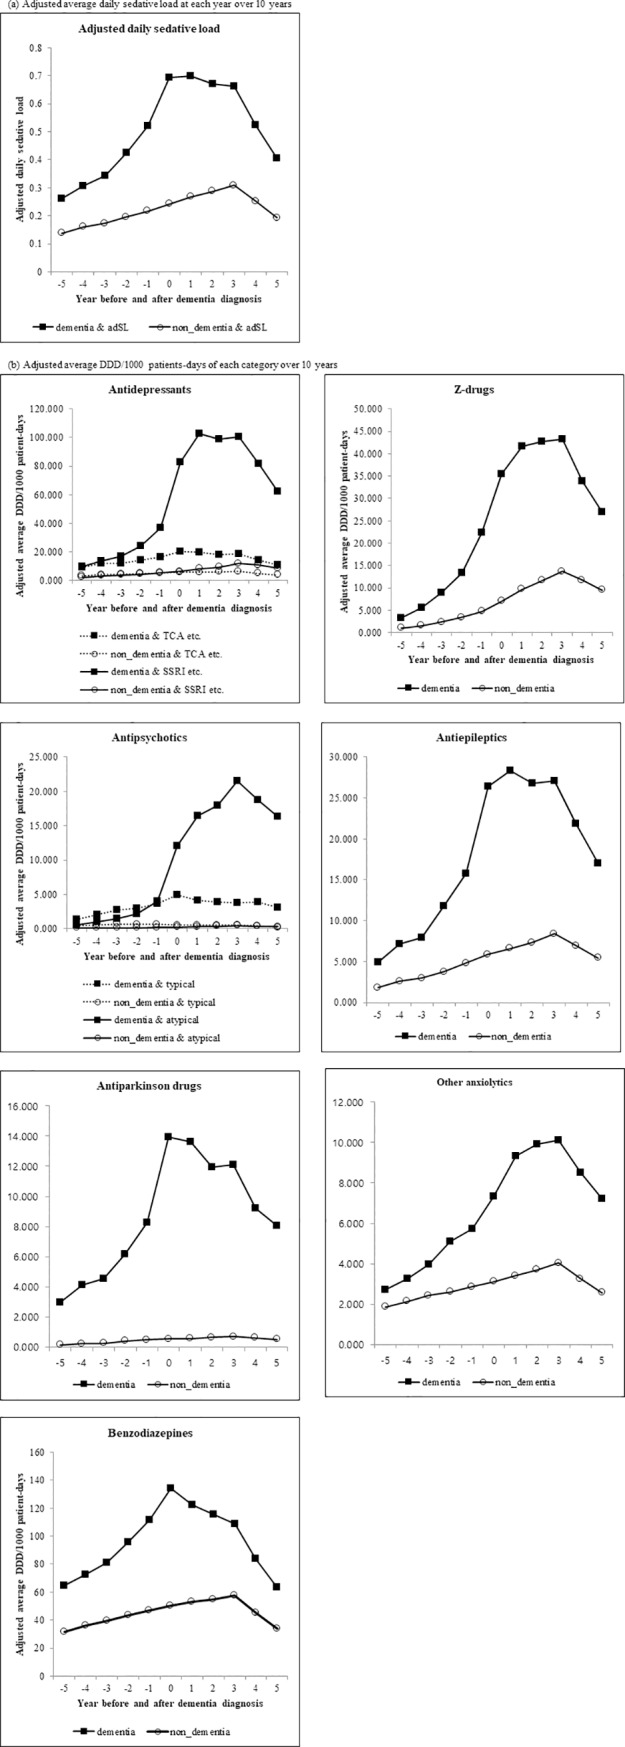
The trend of sedative load and medication use before and after diagnosis of dementia.(a) Adjusted average daily sedative load at each year over 10 years (b) Adjusted average DDD/1000 patients-days of each category over 10 years DDD; Defined daily dose, TCA; Tricyclic antidepressants, SSRI; Selective serotonin reuptake inhibitors, typical; typical antipsychotics, atypical; atypical antipsychotics.